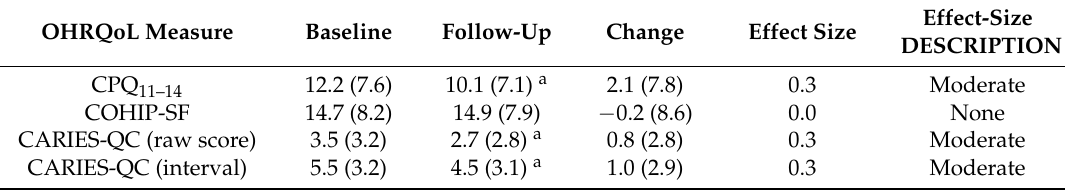
Table 6. Mean overall scores at baseline and follow-up, with effect sizes.